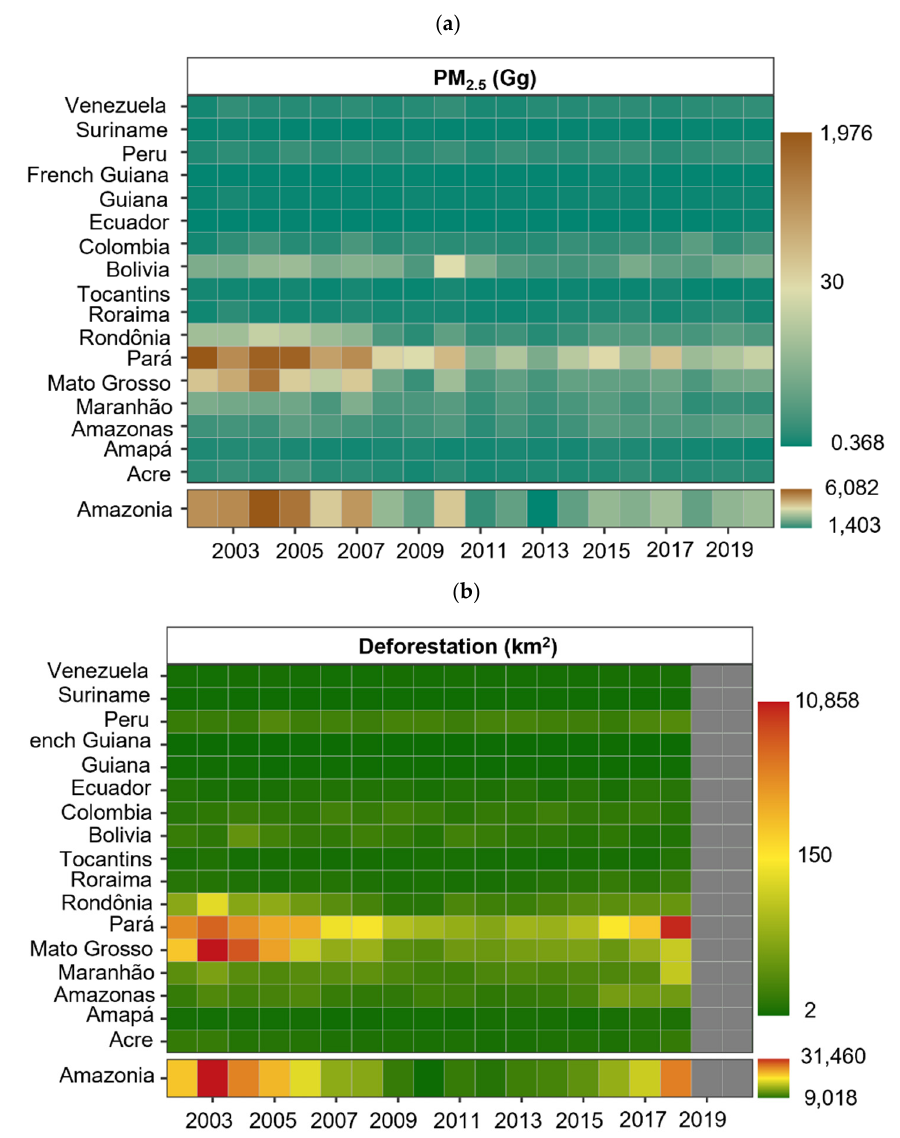
Figure 3. ( a ) Annual total PM 2.5 emitted from biomass burning (Gg) in Amazonia and in its 17 coun- tries/states during 2002–2020; estimates were obtained using the 3BEM_FRP model, and ( b ) annual deforestation (km 2 ) in Amazonia and in its 17 countries/states during 2002–2018; estimates were based on MapBiomas Amazonia Collection 2.0.